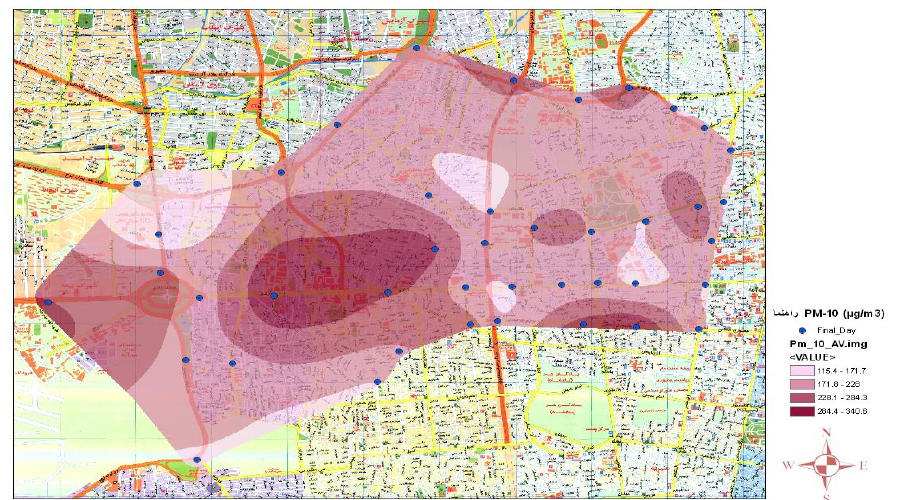
Figure 7. The distribution of mean concentration of PM 10 in the selected region (cold season).